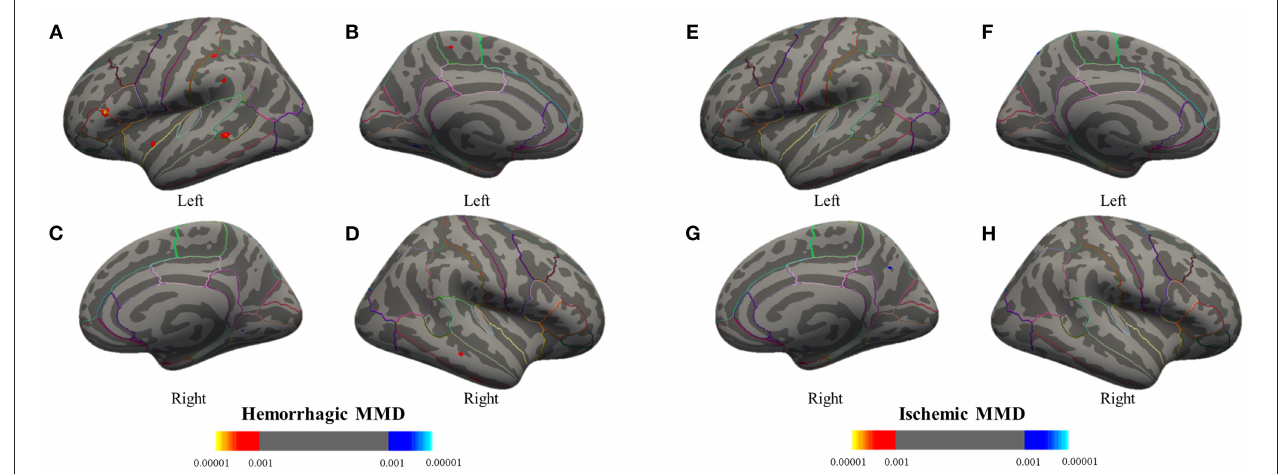
FIGURE 1 | Group analyses between the MMD subtypes and the HC group are performed to detect significant differences in cortical thickness through a general linear model. Results are presented on inflated cortical surfaces. (A–D) The lateral and medial surfaces of the bilateral hemisphere of hemorrhagic MMD. (E–H) The lateral and medial surfaces of the bilateral hemisphere of ischemic MMD. The red to yellow regions indicate thickened cerebral cortex compared with the HC group ( p < 0.001, corrected). The blue to azure region represent thinning cerebral cortex ( p < 0.001, corrected). Hemorrhagic MMD has thickened cortex in the left insula,